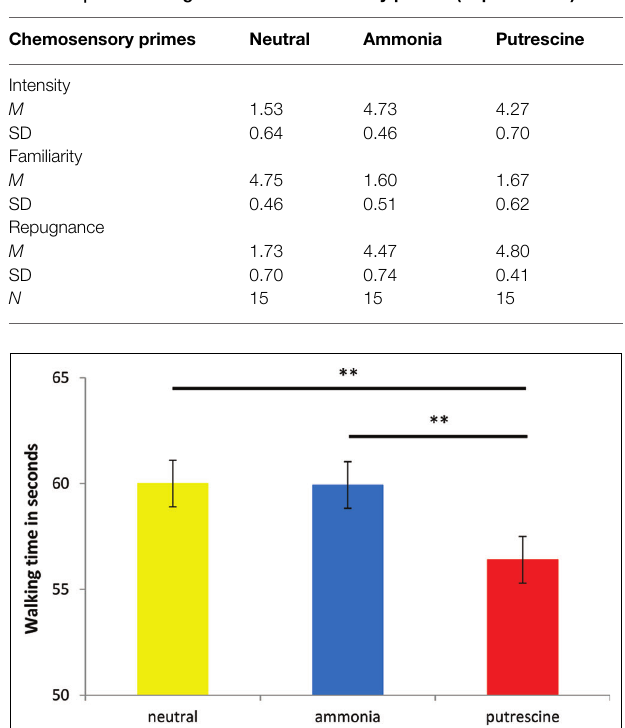
TABLE 3 | Scent ratings for the chemosensory primes (Experiment 2).